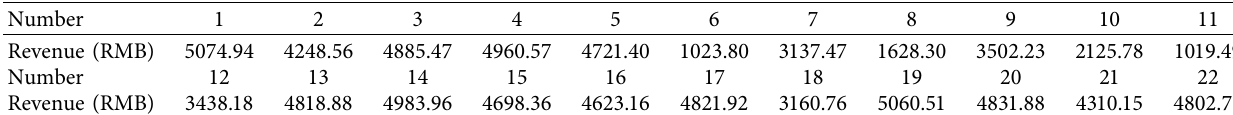
Table 7: Revenue of each charging